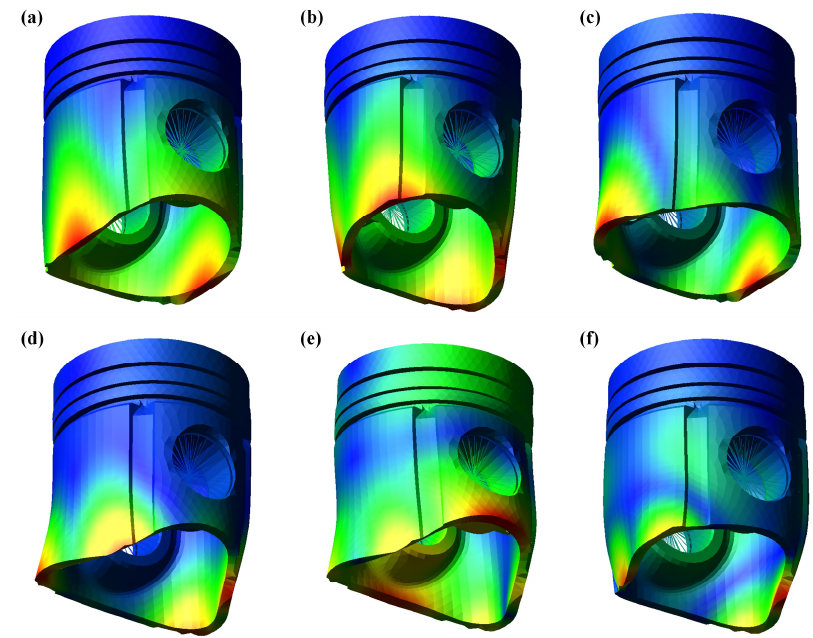
Figure 6. First six mode shapes of flexible piston: ( a ) 5,4883 Hz; ( b ) 6320 Hz; ( c ) 9597 Hz; ( d ) 10,434 Hz; ( e ) 11,370 Hz; ( f ) 13,458 Hz. A comparison of the results using the Default method and the User method is indi- cated in Table 1. Both simulations led to very similar elapsed times. The Default method required 25 min and 10.4 s while the User method was slower with elapsed time of 25 min and 20.2 s. The Default method also needed fewer iterations to converge of 7877 compared to 8311 of the User method. According to these results, the Jacobian quality is not degraded by the user serial finite forward difference method (for the measurements related to the deformation) and it merits further investigation. From the perspective of maximum CPU usage, the complexity of a particular MBD simulation (only 48 measurements in the sub- routine) and a serial sensitivity analysis solution cannot sufficiently utilize the hardware capabilities. Table 1. Computational speed of the simulation using the Default and with the User method for a reduced number of mode shapes.